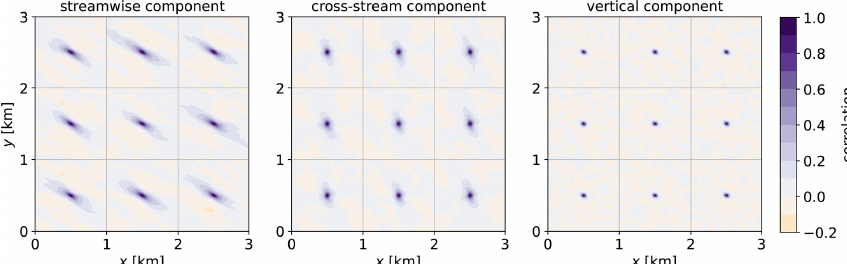
Figure 4. Contour plots of spatial correlation for the three turbulence components for the split-domain approach. Nine domains organized in a 3 × 3 grid are used. The goal is to have more realizations for an ensemble average. For each panel, a spatial average is shown in Fig. 5. The general wind direction, towards the southeast, can be observed in the streamwise component.